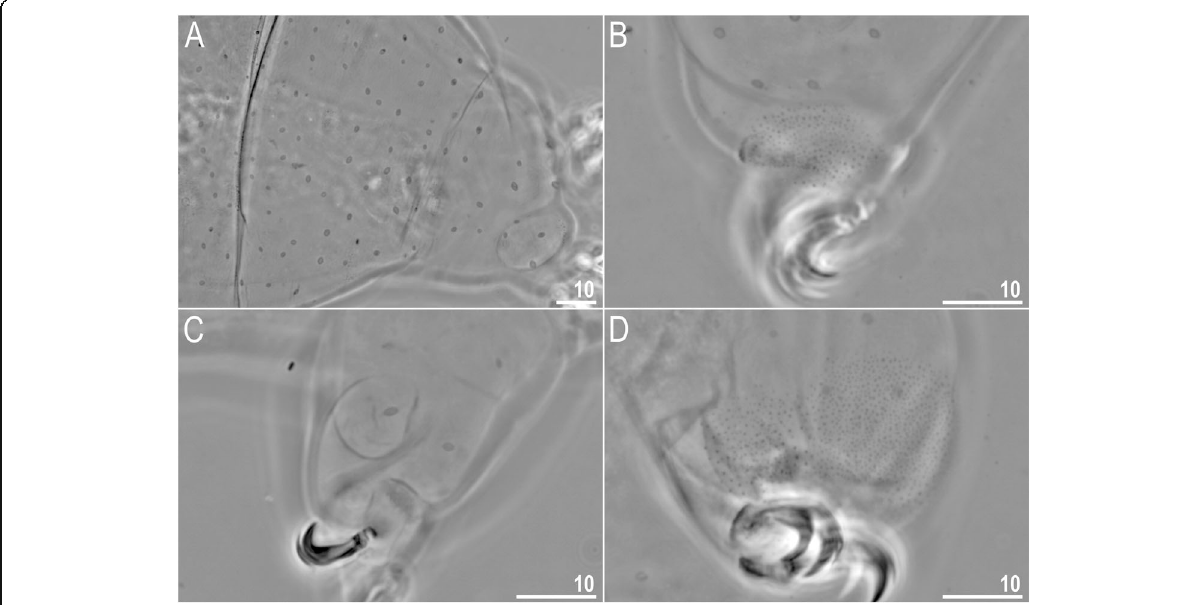
Fig. 31 Macrobiotus margoae sp. nov. from USA (US.057) – body and leg cuticle morphology seen with LCM: a – cuticle on the last body segment without caudal band of granulation; b – granulation on the external surface of leg III; c – internal surface of leg I with evident pulvinus; d – granulation on dorsal surface of leg IV. Scale bar in μ